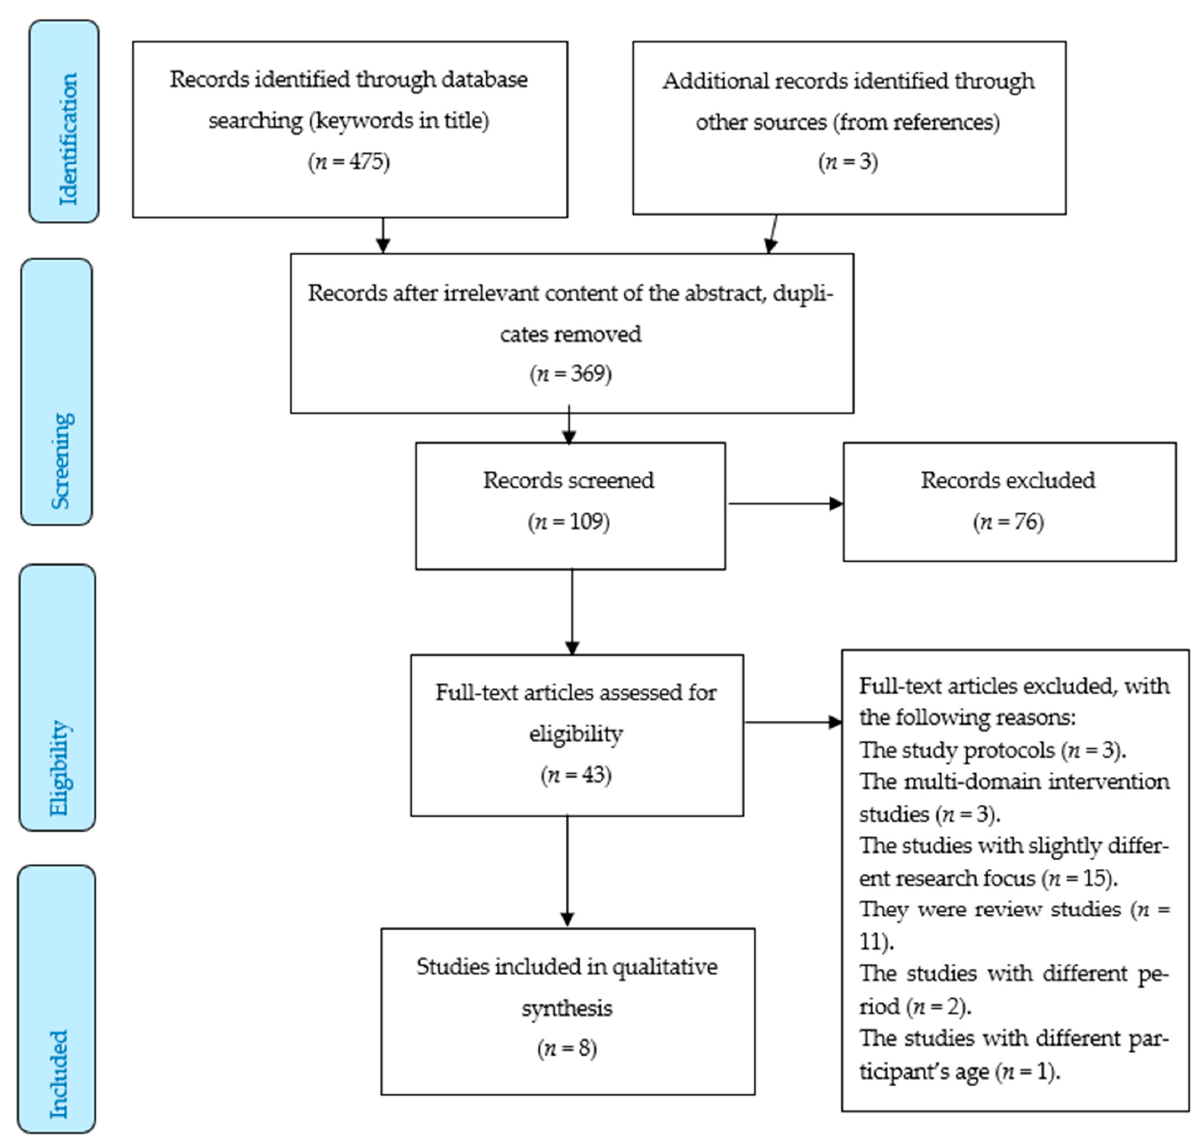
Figure 1. An overview of the selection